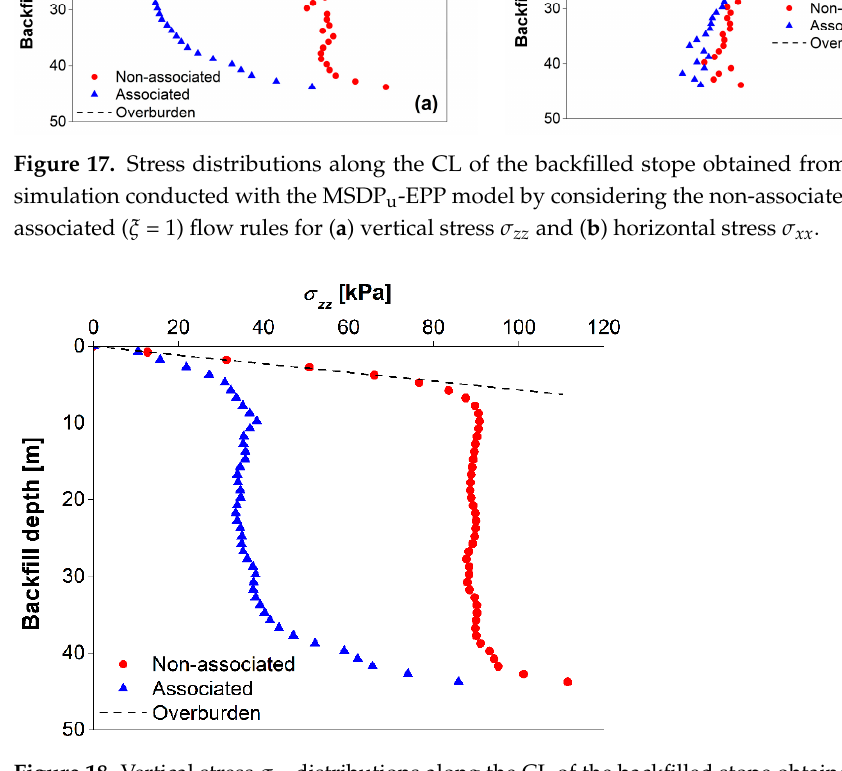
Figure 18. Vertical stress σ zz distributions along the CL of the backfilled stope obtained from numerical simulation conducted with the MC-EPP model by considering the non-associated (dilation angle φ d = 0 ◦ ) and associated ( φ d = φ = 31 ◦ ) flow rules; other material parameters are φ = 31 ◦ , c = 3.8 kPa and T 0 = 0.2 kPa.